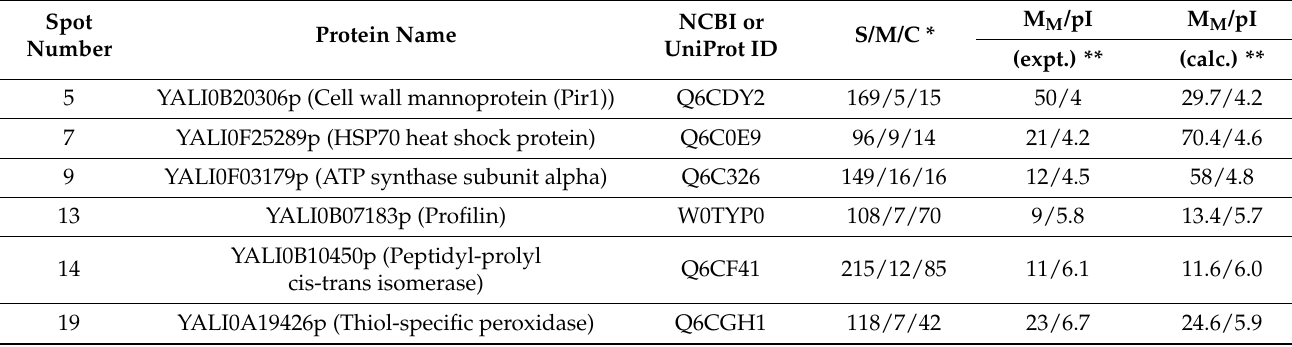
* S/M/C—the Mascot Score is an indicator of conformity or “scorecard”; match peptides are the number of matched peptides; coverage is the percentage of the complete amino acid sequence of the protein using the identified peptides. ** M M /pI (exp.) are the obtained estimates according to electrophoretic mobility in the DE, M M /pI (calc.) are the estimates made using the data on the amino acid sequence, taking into account signal peptide removal, but with no consideration of other post-synthetic modifications using the ExPASy Compute pI/M w tool